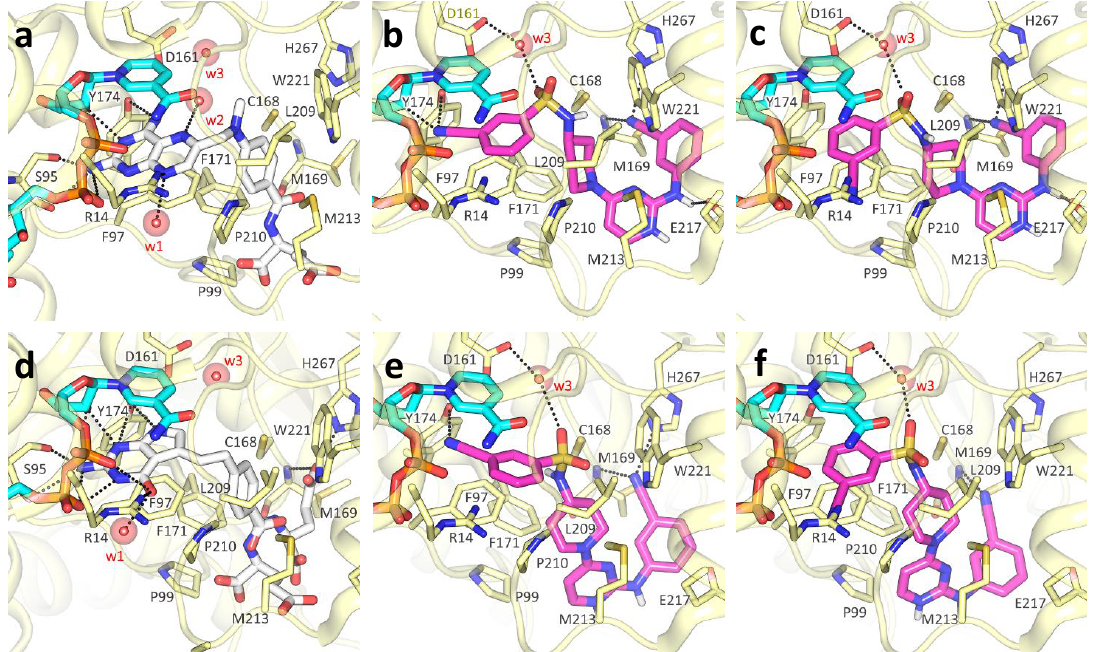
Figure 5. TCMDC-143249 docking poses in TbPTR1. ( a ) MTX (white) main polar contacts in PDB ID 2C7V. ( b , c ) Two main orientations of TCMDC-143249 (magenta) docked in PDB ID 2C7V. ( d ) Pemetrexed (white) main polar contacts in PDB ID 2X9G. ( e , f ) Two main orientations of TCMDC-143249 (magenta) docked in PDB ID 2X9G. Protein is represented as light yellow cartoon, with relevant binding site residues depicted as sticks and labelled. NADPH cofactor (cyan) and ligands are shown as capped sticks; polar interactions between ligands and protein are shown as black dashed lines. Water molecules, indicated when not displaced by the docking, are reported as red spheres with their Van der Waals radius visible in transparency. For clarity, polar hydrogens are shown for ligands only.